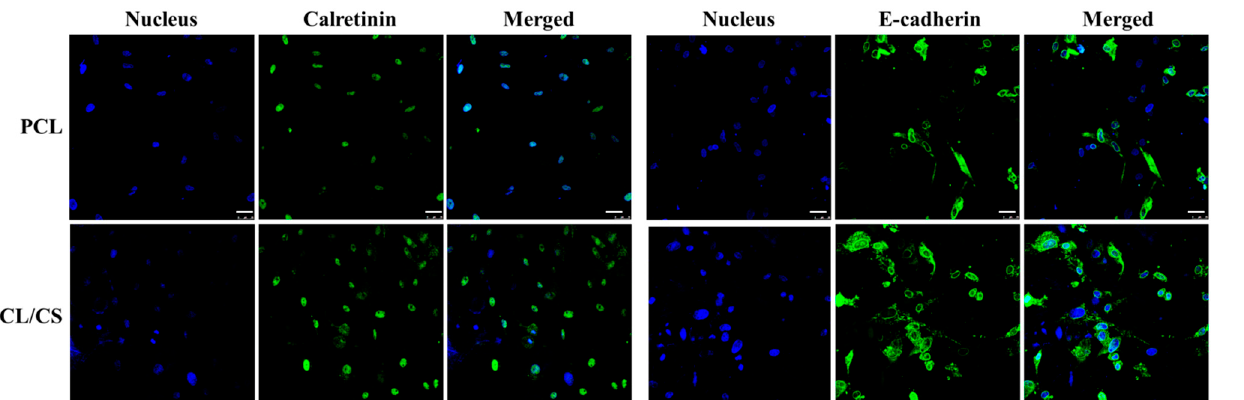
Figure 8. The immunofluorescence (IF) staining of calretinin and E-cadherin produced by mesothelial cells cultured in PCL and PCL/CS nanofiber membranes for 7 days. The proteins were stained green using a fluorescein (FITC)-conjugated secondary antibody that can bind with the primary antibody against calretinin or E-cadherin. The nuclei were stained blue by Hoechst 33258. Bar = 25 µm.